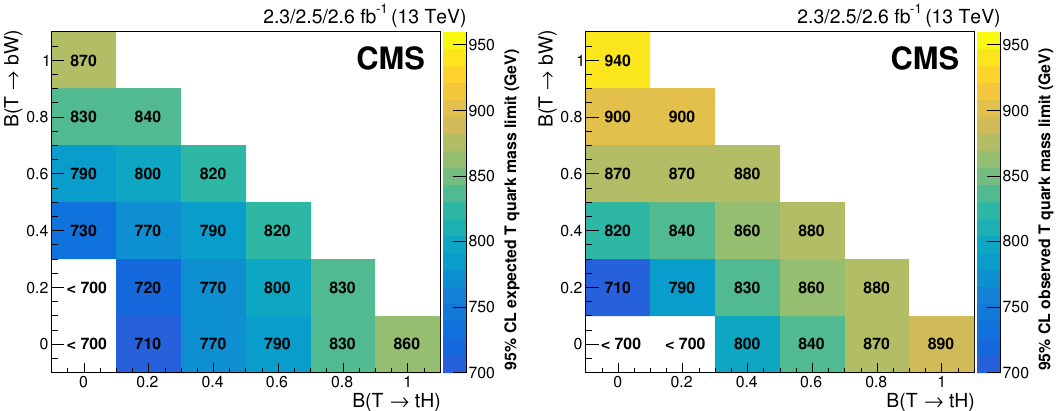
Figure 14 . The expected (left) and observed (right) at 95% CL lower limits (Bayesian) on the T quark mass for a variety of T ! tH and T ! bW branching fraction combinations, indicated by the coordinates at the center of each box, after combining the boosted W and boosted H channels. A limit of < 700 GeV indicates that this search is not sensitive to T quark decays with that branching fraction